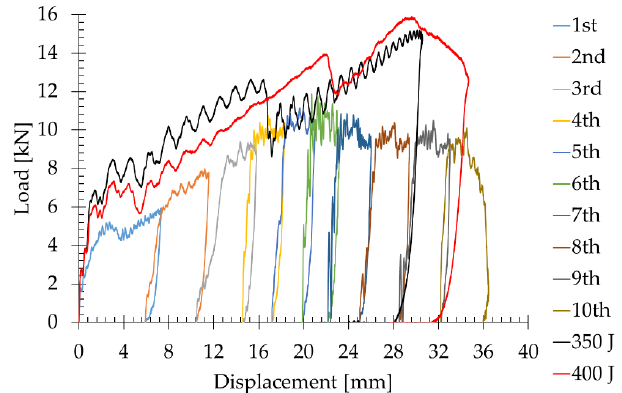
Figure 10. Load-displacements curves obtained by three tests on Type IV specimens.